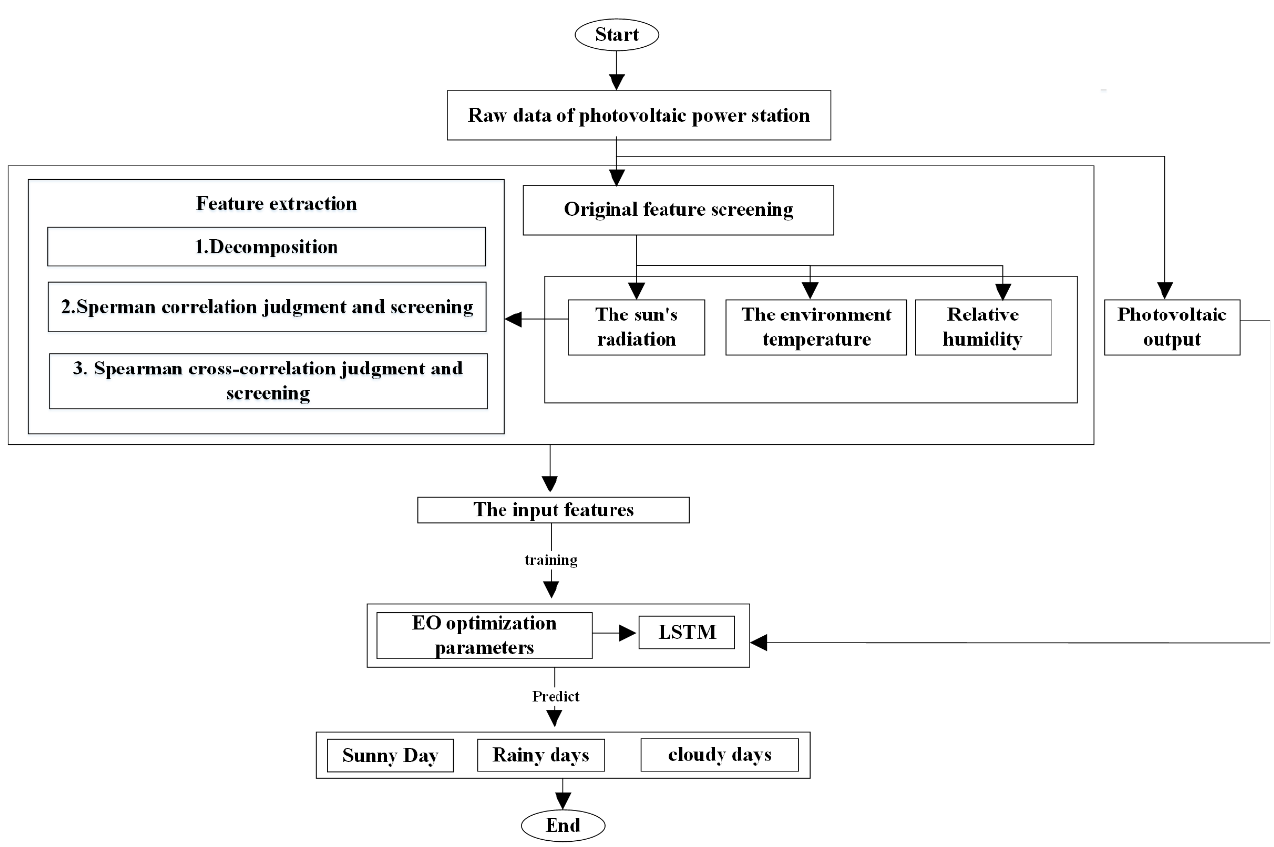
Figure 2. Flowchart of the proposed model performance.